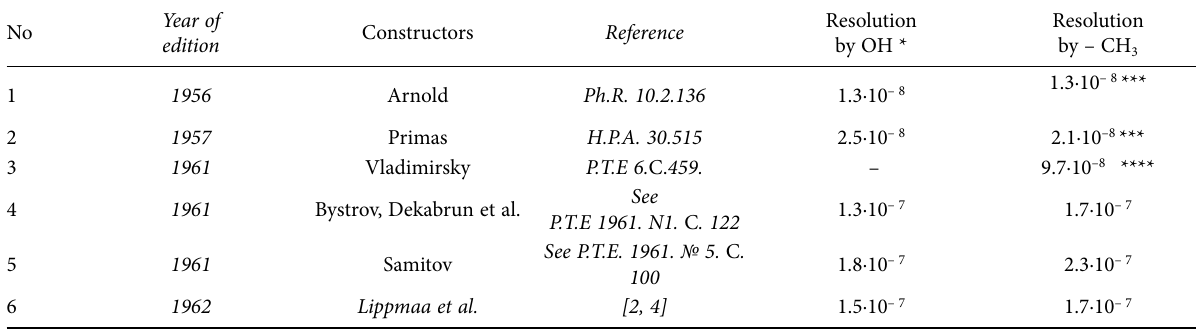
Table 1. Resolution of some NMR spectrometers of own